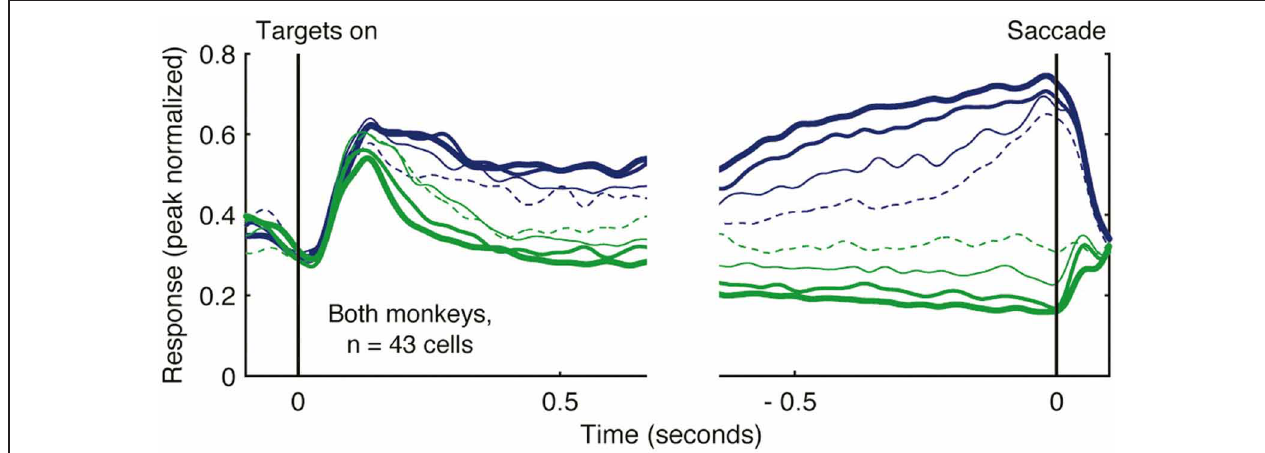
FIGURE 3 | Activity of LIP neurons scales with action value in a decision-making task. Monkeys decided whether to saccade toward one of two alternative targets (red or green) under conditions in which the reward that each target would deliver changed dynamically as a function of choice and reward history. Spike density functions plot the mean firing rate of 43 LIP neurons as a function of the local fractional income, or the proportion of